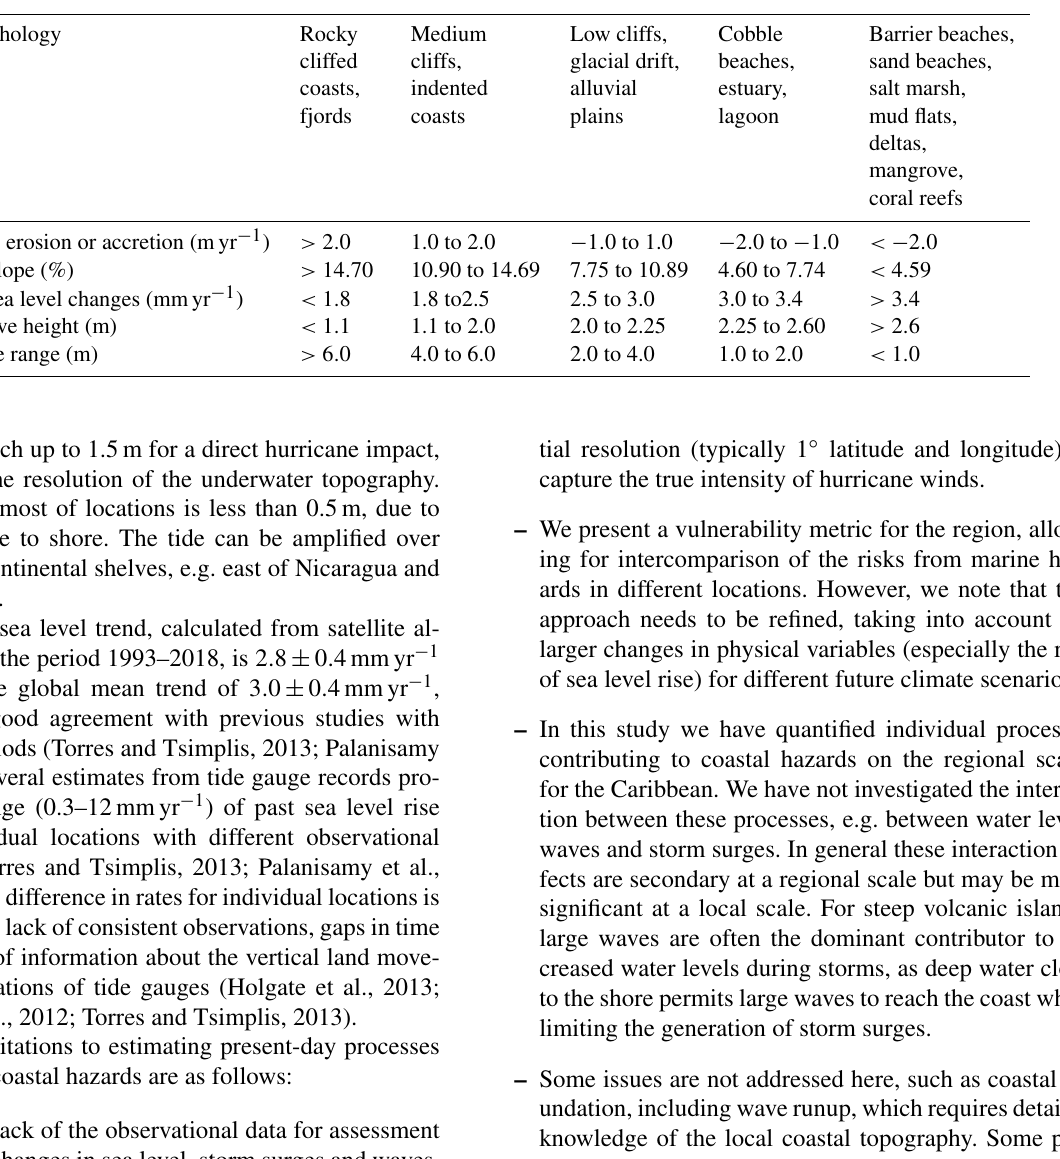
Table 1. Ranges for vulnerability ranking of variables on the Atlantic and Caribbean coasts (from THK). Variables Very low Low Moderate High Geomorphology Rocky Medium Low cliffs, Cobble Barrier beaches, cliffed cliffs, glacial drift,